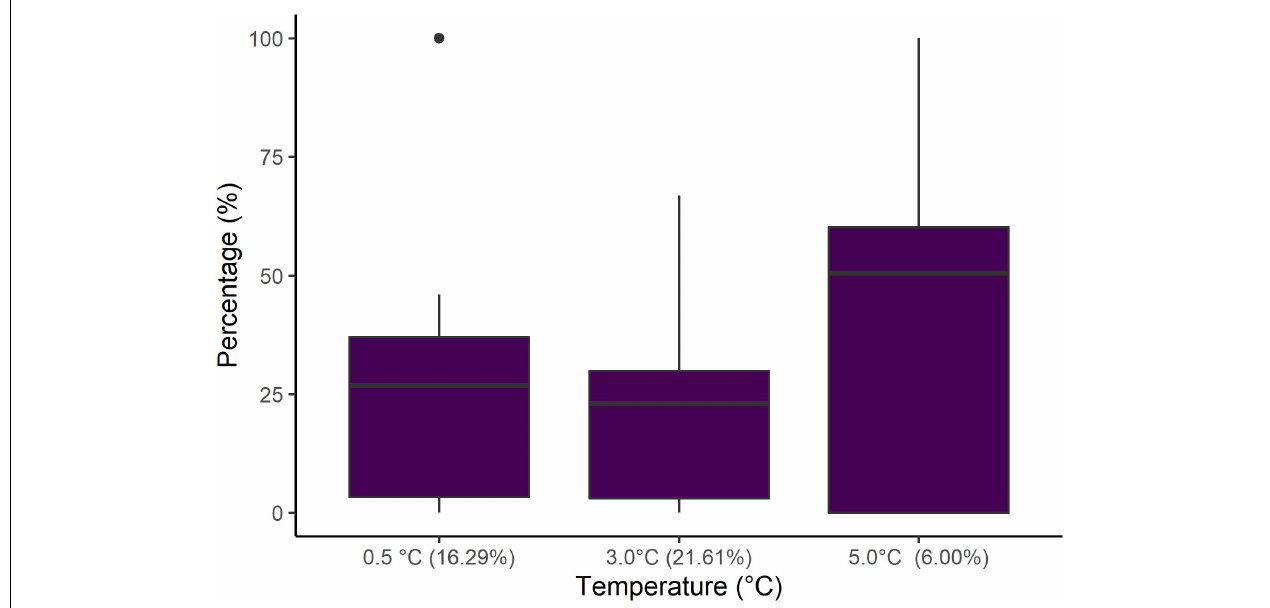
FIGURE 5 | Percentages of malformed nauplii. All hatched nauplii in our field experiments were categorized as either healthy or malformed. This figure presents the percentage of malformed nauplii for each of the three temperature treatments. On the x -axis the number in brackets is the mean total hatch percent at the corresponding temperature. The error bars show standard deviation and the horizontal bar shows the mean percentage